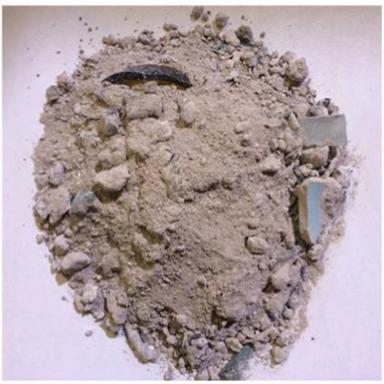
Sample of a five-month mixed dry IBA.